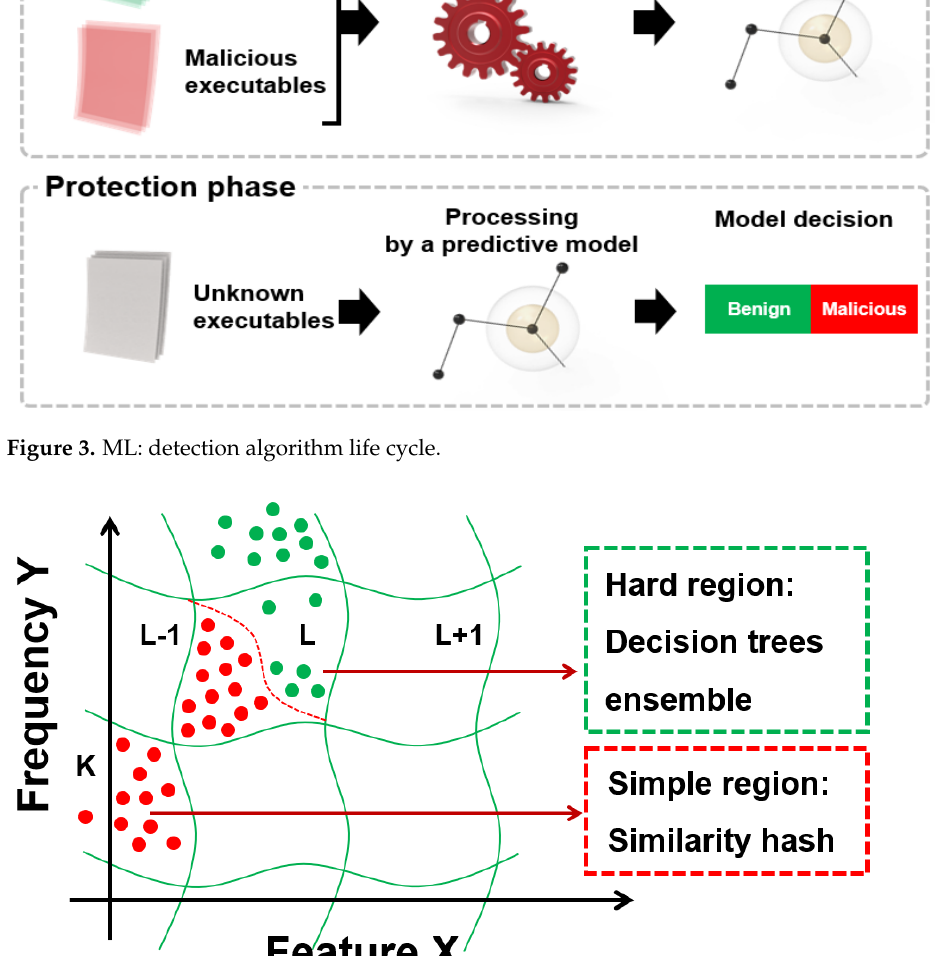
Figure 3. ML: detection algorithm life cycle.